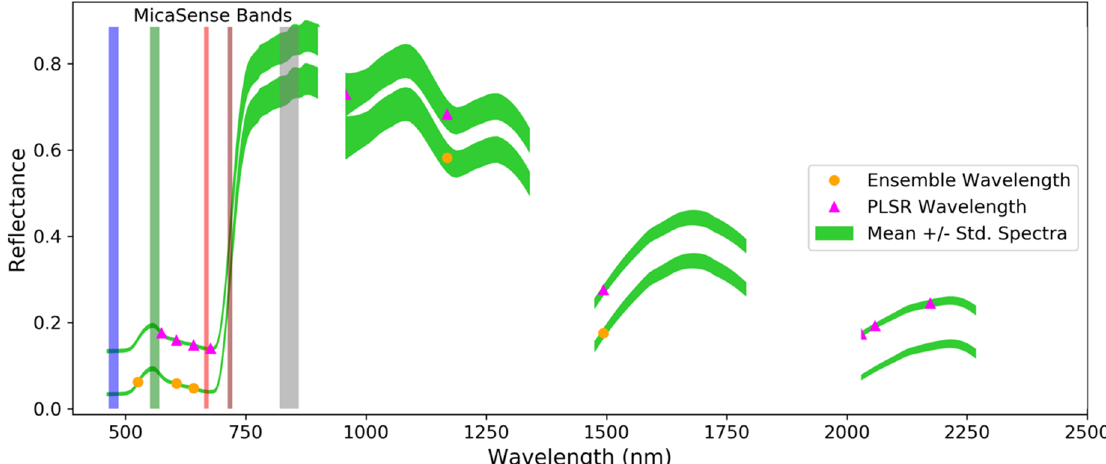
Figure 3. Average grapevine spectrum with the optimal wavelengths for nitrogen content prediction found using the ensemble (5 orange circles) and PLSR (10 magenta triangles) feature selection methods. The PLSR points are plotted on a spectrum shifted upward to differentiate between the wavelengths selected by the two methods. The location of the MicaSense RedEdge multispectral sensor blue, green, red, red-edge (brown), and near-infrared (gray) bands are noted in the VNIR for the context of a typical multispectral camera used in precision agriculture. The selected wavelengths are plotted for all the nutrients as a histogram in Figure 4 to show the frequency of wavelengths chosen from regions of the vegetation spectrum in 25-nm-width bins. The histogram for the ensemble and PLSR methods is displayed along multispectral camera bands for reference. A number of observations can be made based on Figure 4: (i) with the exception of blue, the selected bands cover the visible region of the spectrum, while there are distinct peaks in the blue–green and deep red for both methods; (ii) an orange peak and peak at the top of the red edge are also present for the ensemble method; (iii) there is a lack of bands selected in the NIR plateau range, especially around the typical NIR multispectral band centered at 840 nm; and (iv) the selected wavelengths in the SWIR region favored the edges of the strong water absorption features, although the PLSR method also selected wavelengths at a high frequency near 2125